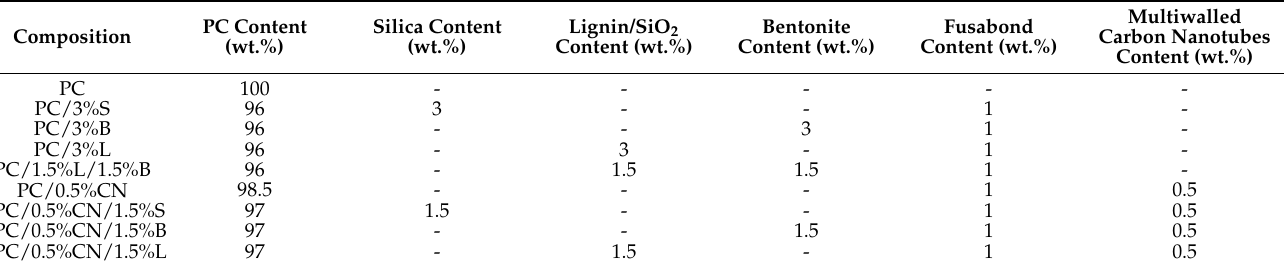
Table 1. Compositional data of the